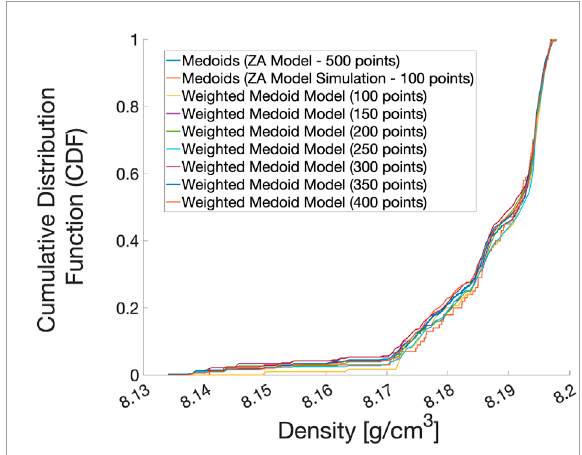
FIGURE 7 Cumulative distribution of material density values predicted by the Taylor Anvil simulation. Each line, except one, represents a proposal distribution determined by an input sub-sample size as indicated in the legend. One line represents the target distribution. Naturally, as the size of sub-sampled input points used to construct the proposal distribution approaches 500, the closer the proposal distribution will be to the target distribution.